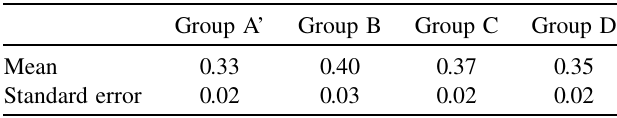
TABLE XIII. Average group presentation grades for pre prob- lem solution.